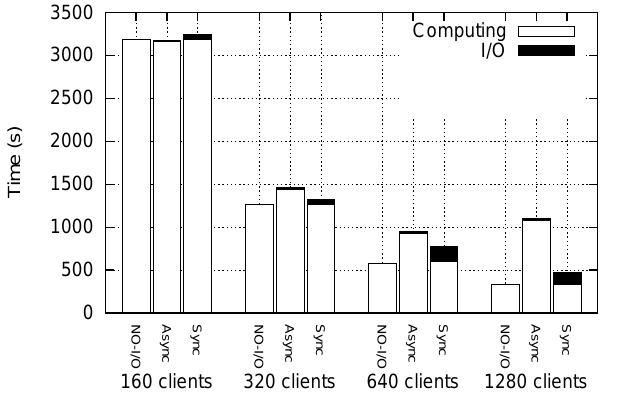
Fig. 7. The overall running time of CICE with different I/O ap-